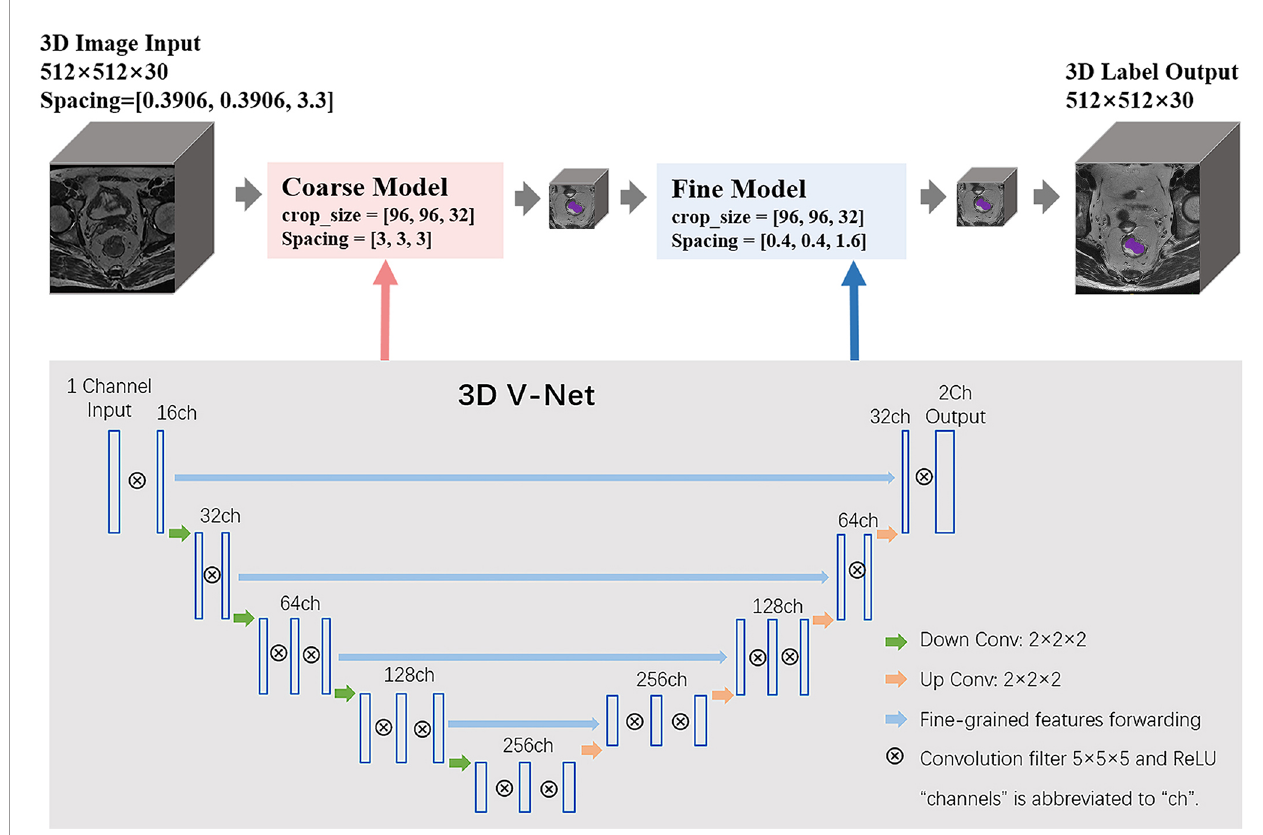
FIGURE 2 | The schematic network architecture of cascade